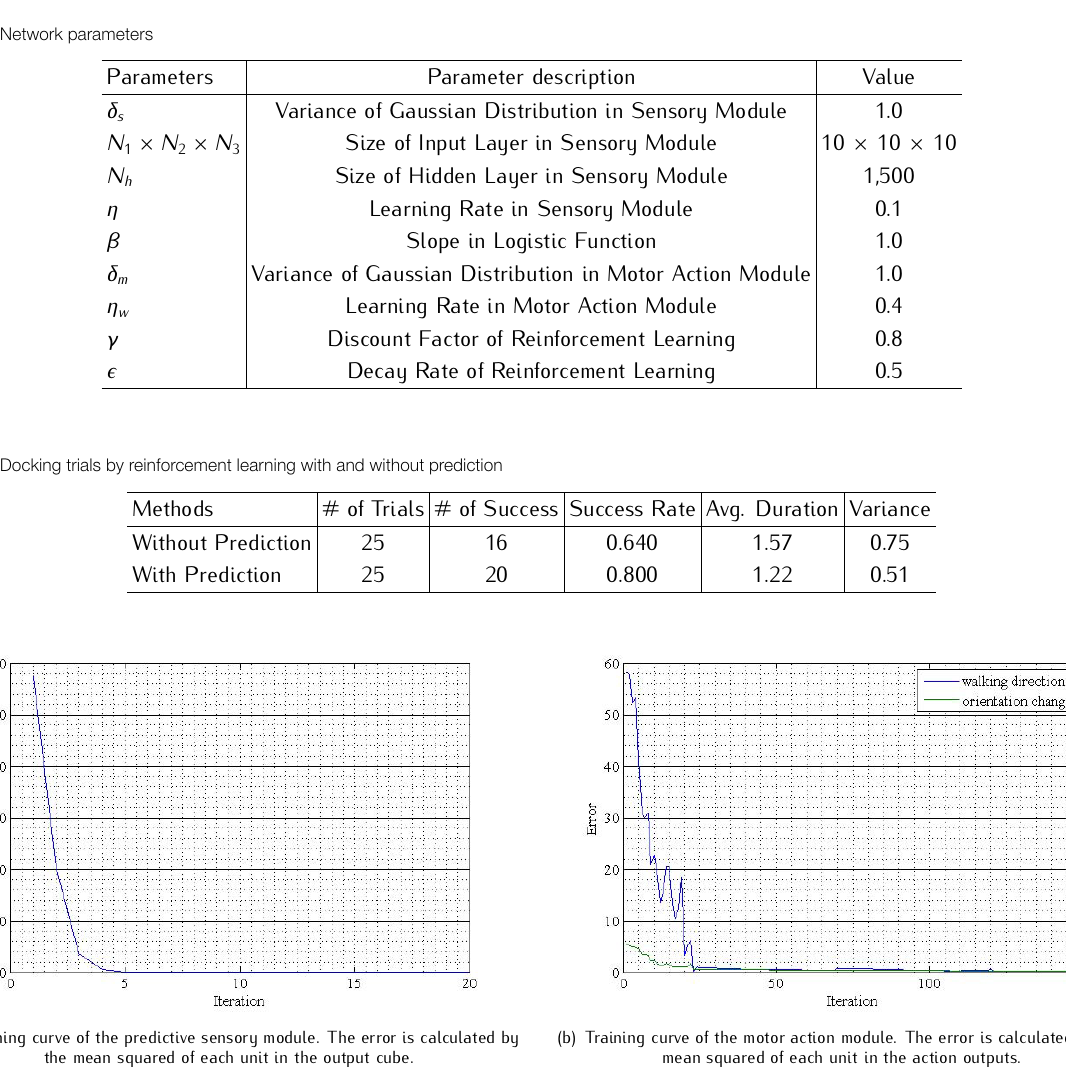
Figure 4. Training curves of two